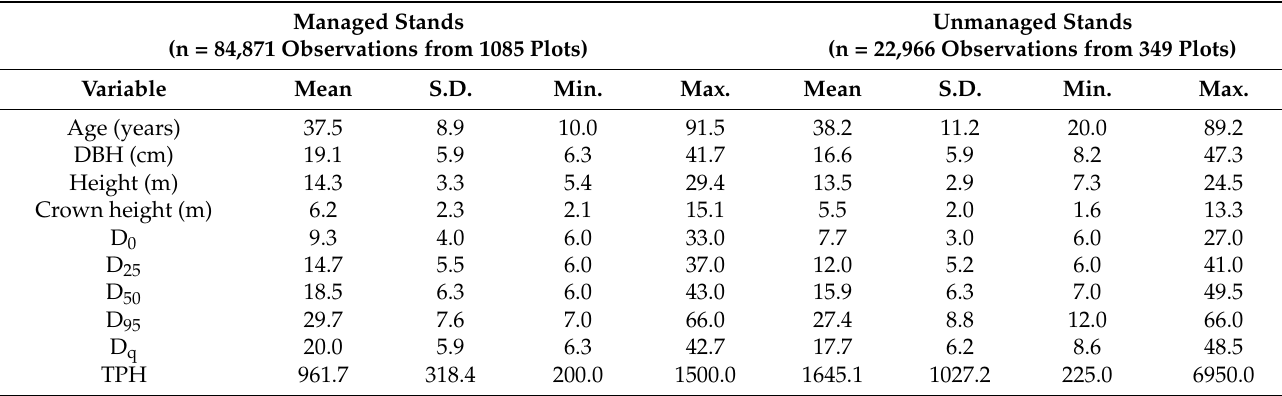
Table 4. Summary of observed statistics for Pinus densiflora stands in South